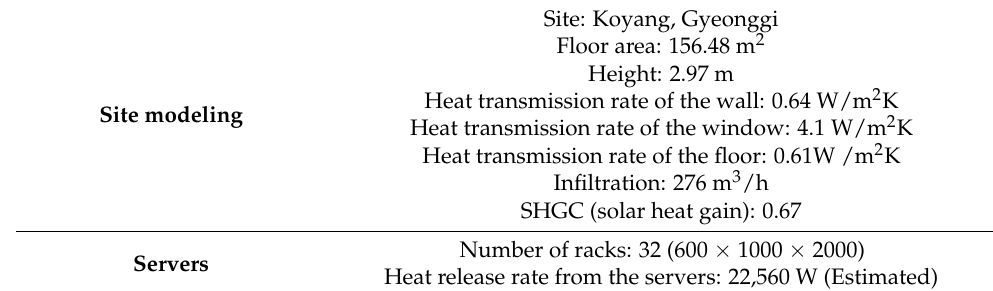
Table 1. Analysis model condition.